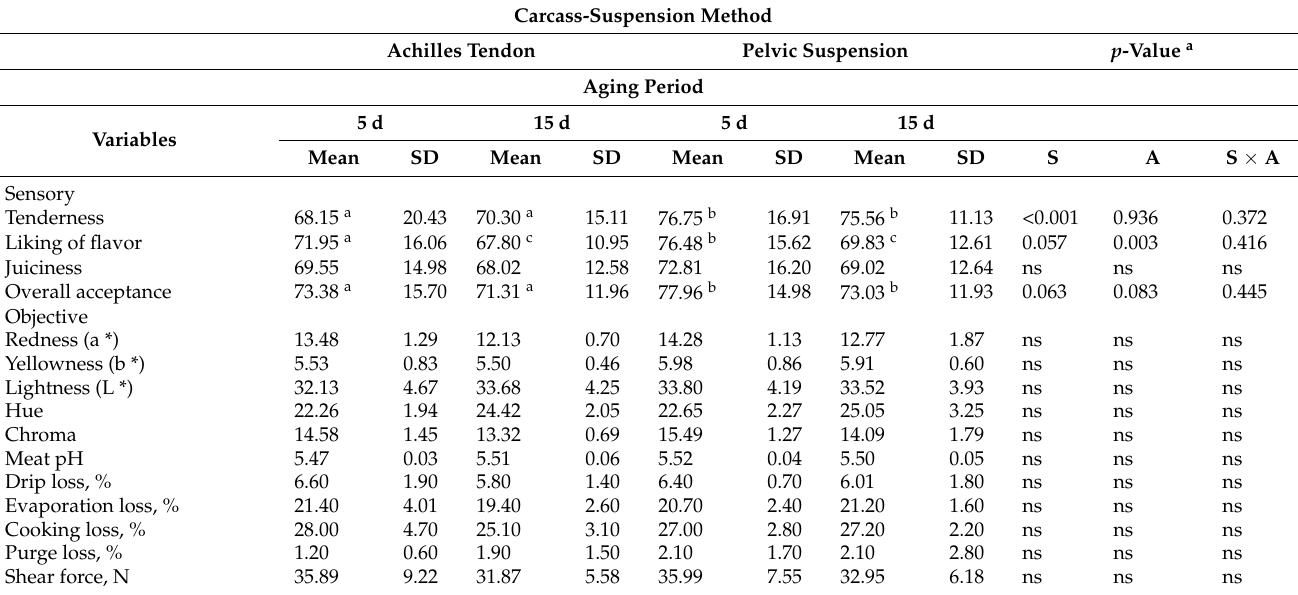
Table 3. Sensory and objective meat quality traits of aged samples (5 or 15 days) from feedlot-finished Brangus heifers whose half-carcasses were suspended by the traditional Achilles tendon method ( n = 20) or by the pelvic bone ( n =